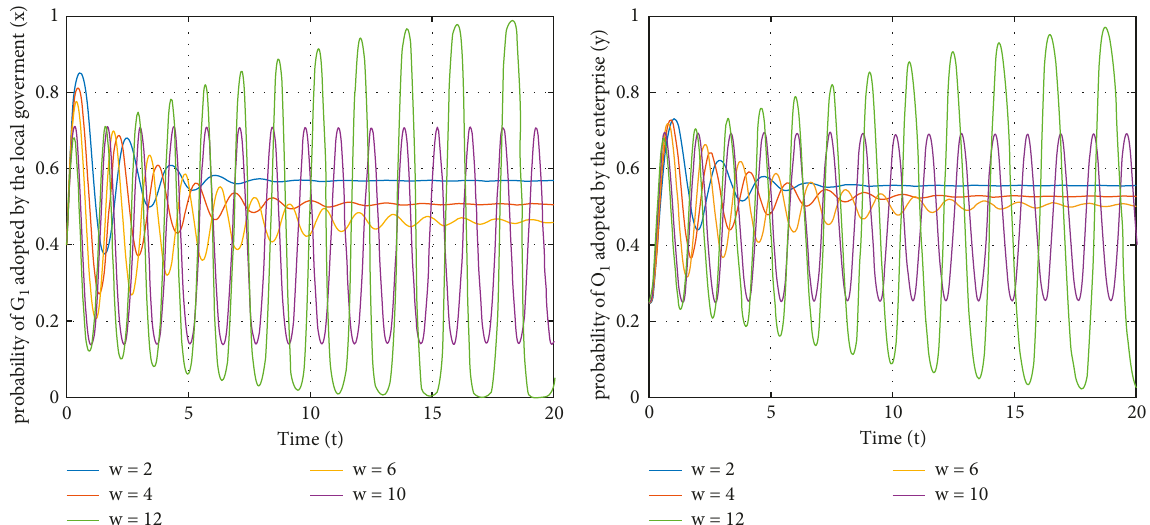
Figure 10: The impact of raising the upper limit of w on local government and enterprise.